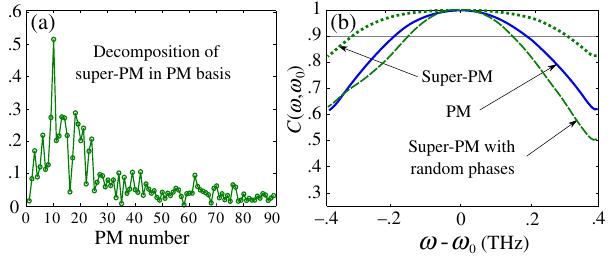
FIG. 3. (a) Decomposition of the widest super-PM in the basis of PMs, which are numbered from short to long delay times. The super-PM bundles together PMs with similar delay times. (b) Spectral correlation functions of the widest super-PM (green dotted line), the widest PM (blue solid line), and the widest super- PM with phases of constituent PMs randomized (green dashed line). The bandwidth enhancement of super-PMs is sensitive to the phases of constituent PMs, indicating that super-PMs are formed by interference of